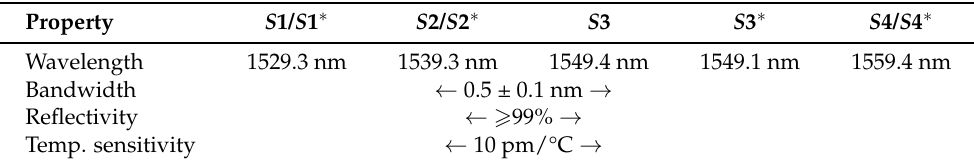
Table 2. Properties of the fibre Bragg grating sensor pairs S 1/ S 1 ∗ , S 2/ S 2 ∗ , S 3/ S 3 ∗ and S 4/ S 4 ∗ (FORC-Photonics; Moscow, Russia). Unlike other sensor pairs, S 3/ S 3 ∗ had different wavelengths and are mentioned